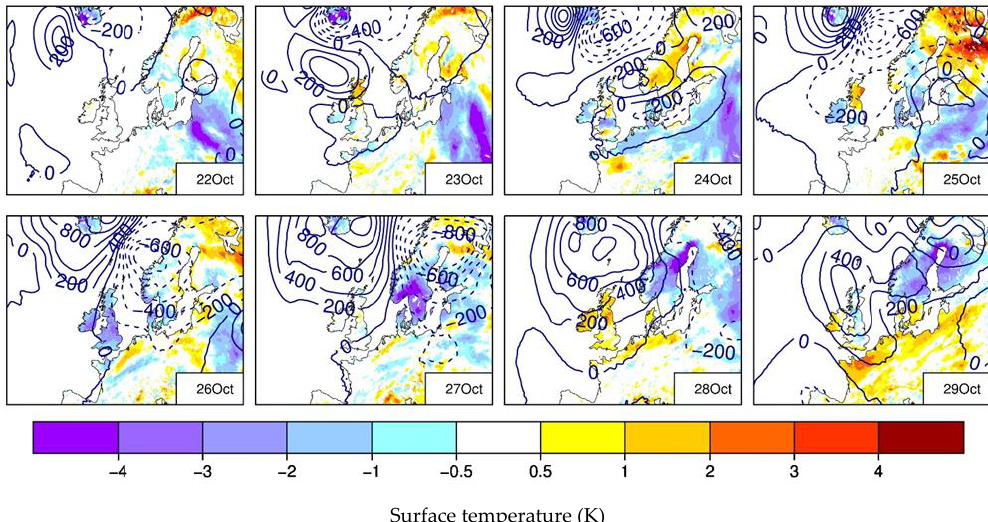
Figure 11. Difference of daily mean geopotential height at 500 hPa ((gpm), contour) and surface temperature ((K), shaded) between CCLM1 and CCLM4. Time period: 22–29 October 2013.